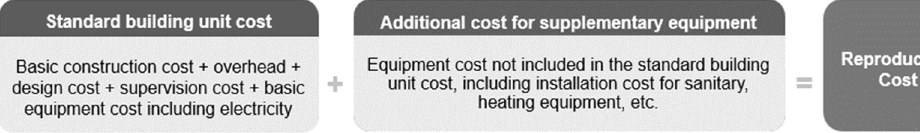
Table 6. Example of a building unit price index.